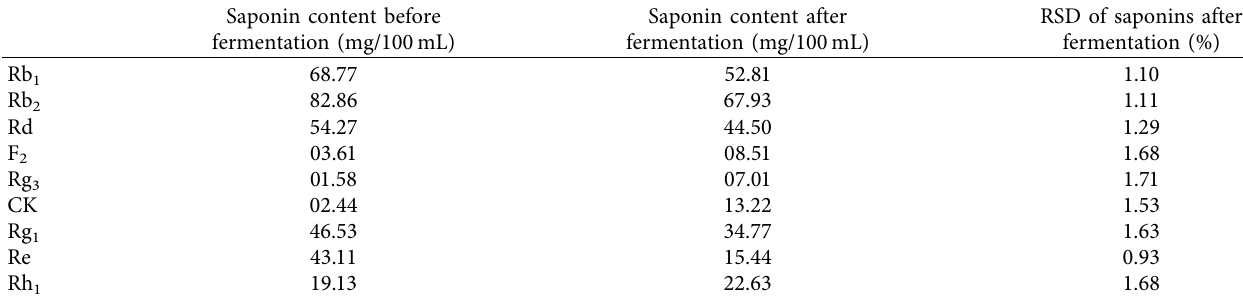
Table 3: Result of the optimal fermentation